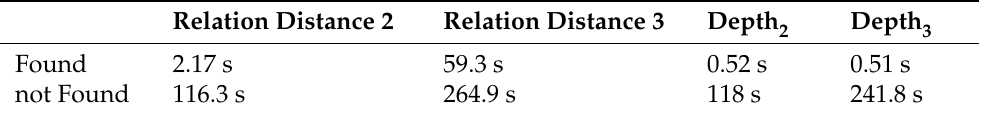
Table 6. Average query execution running